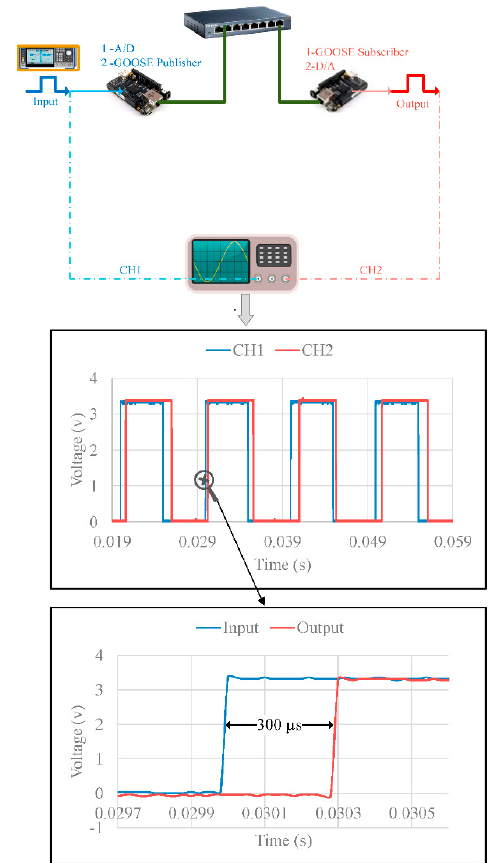
Figure 5. Results from Case 1.